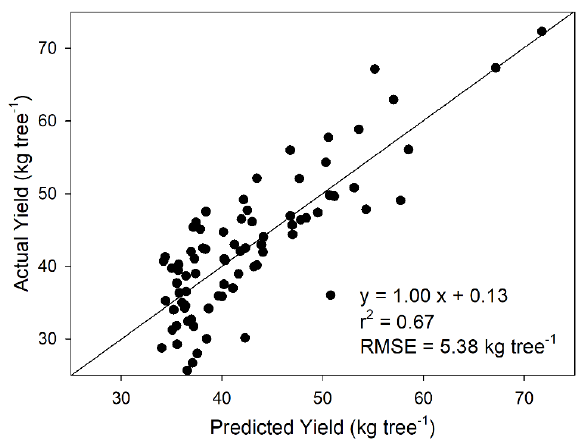
Figure 9. Regression equation obtained for the predicted and the actual yield of sweet cherry trees.